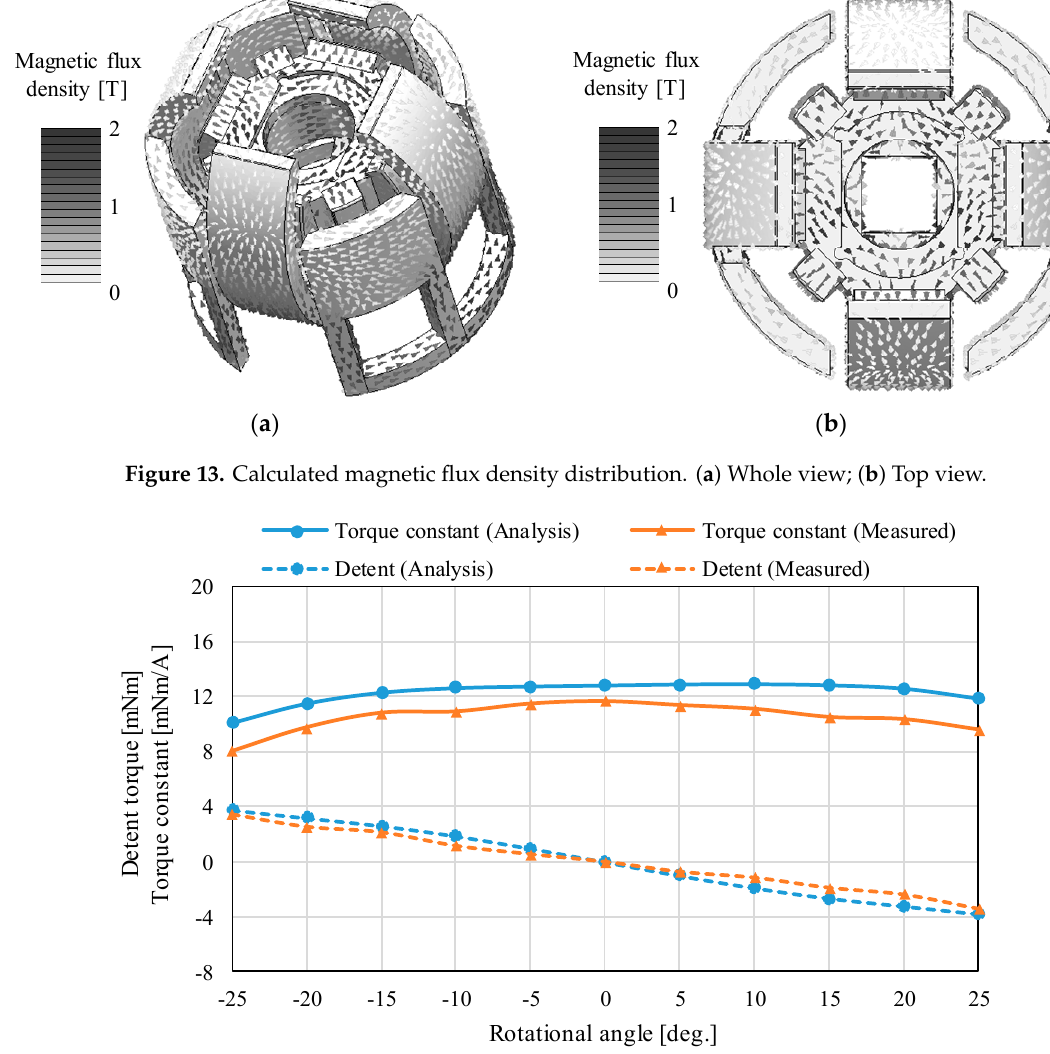
Figure 15. Torque characteristics in the Z -axis. 4.3. Experimental Setup The experiment environments of the torque measurement are shown in Figure 16. The torque characteristics in the X -axis and Z -axis are measured using a force sensor (MAF-3, WACOH-TECH Inc., Toyama, Japan) and a torque sensor (TCF02N, Tohnichi Mfg. Co., Tokyo, Japan), respectively. The mover is forcibly rotated by a servo motor (HG-AK0336, Mitsubishi Electric Corp., Tokyo, Japan). The servo motor is controlled by a PLC (QD75MH2 and Q03UDCPU, Mitsubishi Electric Corp.) and a servo amp (MR-J4W2-0303B6, Mitsubishi Electric Corp.). The rotational shaft of the motor is connected to the mover using links and mechanical coupling. The resolution of the encoder is 262,144 pulses/rev. To measure the torque constant of the actuator, DC currents to the actuator are supplied by a bipolar amplifier (HAS4014, NF Corp., Kanagawa, Japan).